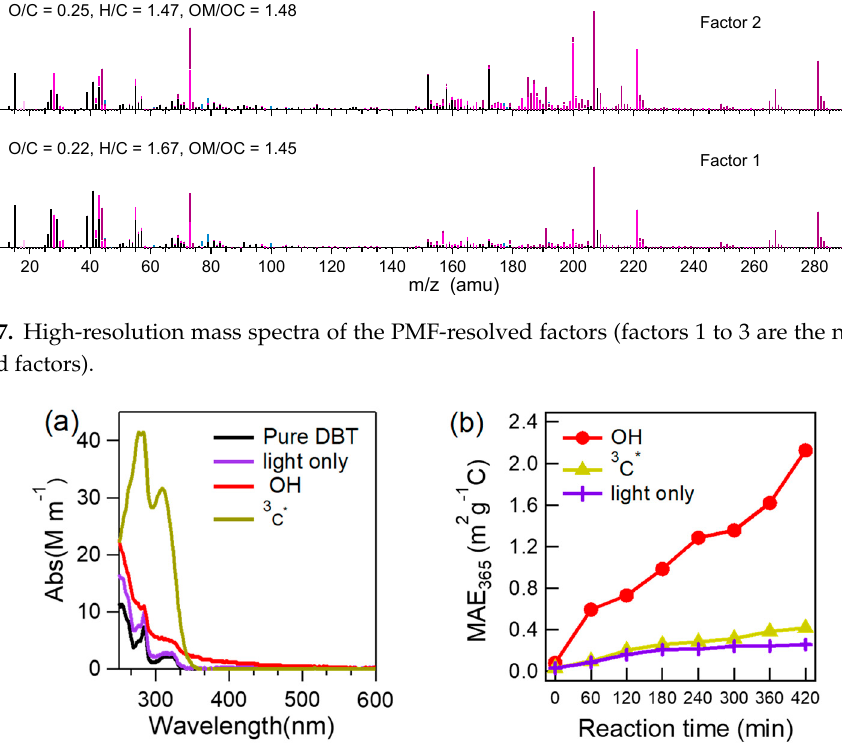
Figure 8. Light absorption spectra of the final illuminated solutions ( a ), and temporal variations of